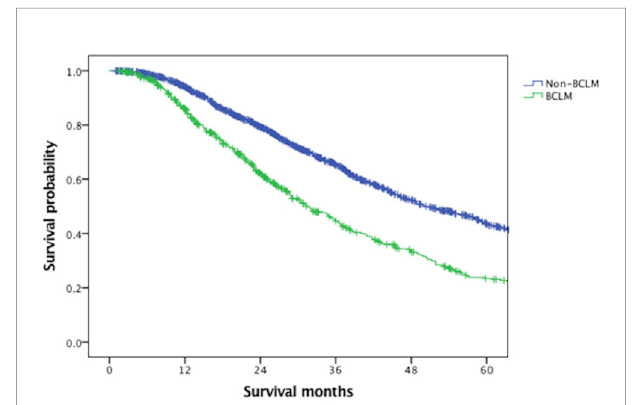
FIGURE 1 | Overall survival of BCLM and non-BCLM patients among the entire population. BCLM, breast cancer liver metastases.